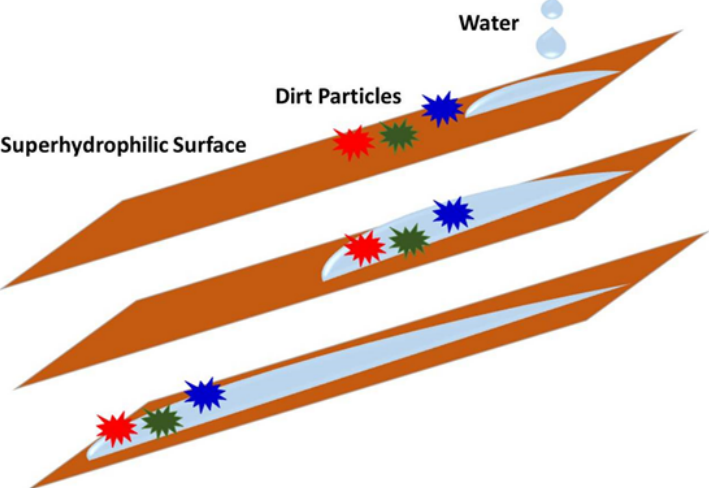
Figure 1. Schematic showing the self-cleaning phenomena on superhydrophilic